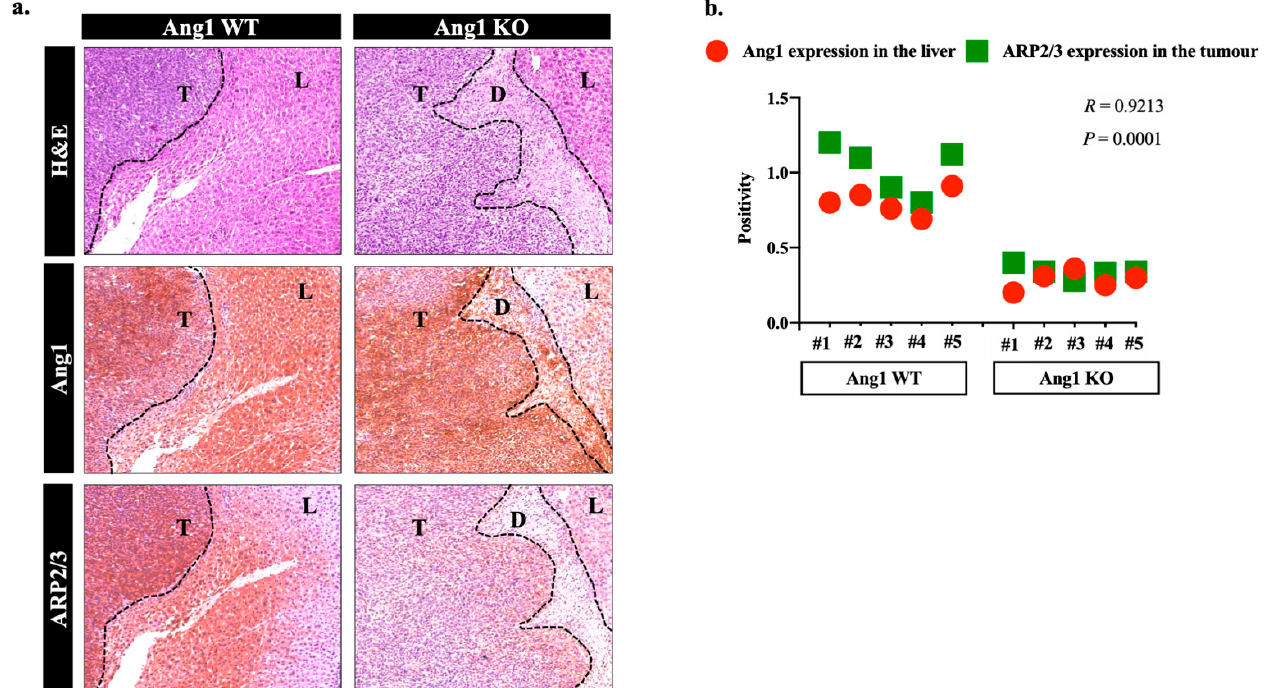
Figure 2. Ang1 presence is essential for ARP2/3 expression in the cancer cells in vivo. ( a ) RepreScheme 1 and ARP2/3 staining of tumour sections generated by intrasplenic injection of mouse colorectal (MC38) cancer cells into wild type (Ang1 WT) and Ang1 knockout (Ang1 KO) mice (left panel). D: Desmoplastic ring, L: Liver tissue, T: Tumour. ( b ) Represents the Correlation between Ang1 expression in the liver tissue and ARP2/3 expression in the tumour cells using Pearson correlation analysis.